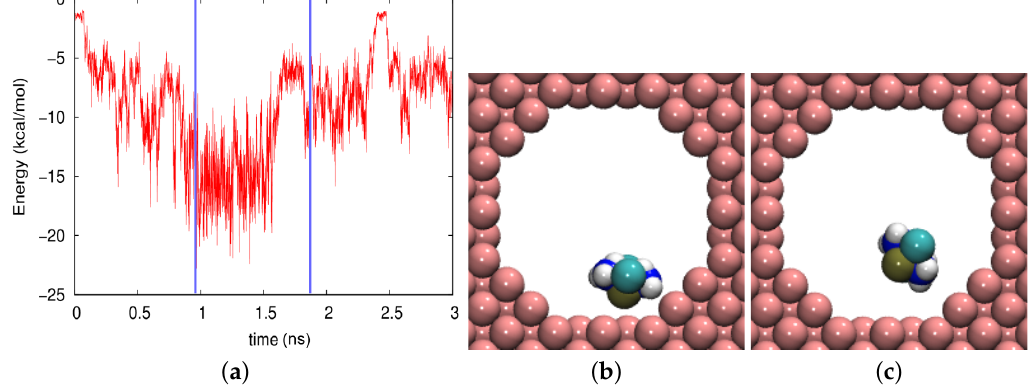
Figure 9. ( a ) Evolution of the vdW energy between the cisplatin molecule and the gold pore during the diffusion process. ( b , c ) show snapshots at times of ( b ) 968 ps and ( c ) 1884 ps. These times are marked in ( a ) by vertical blue